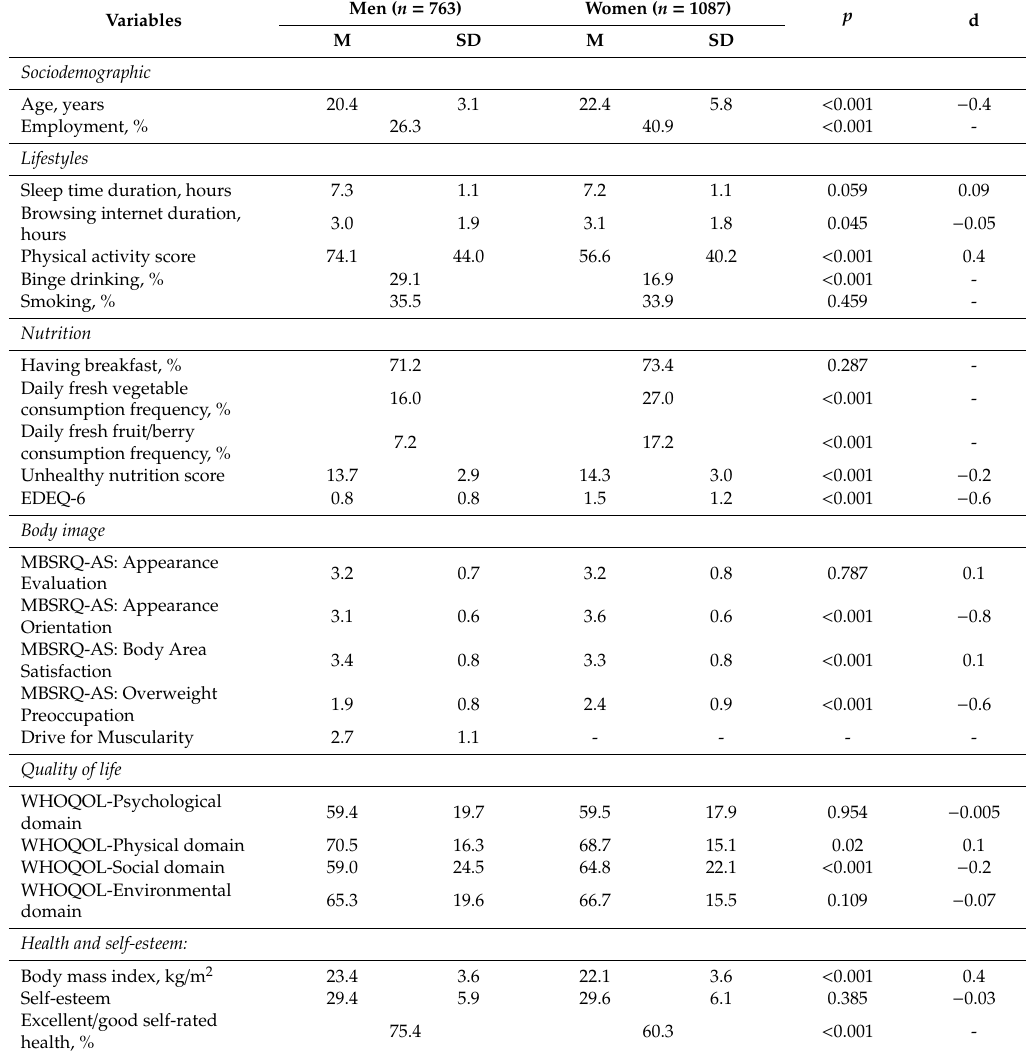
Table 1. Comparison of the study variables for male and female students ( n =